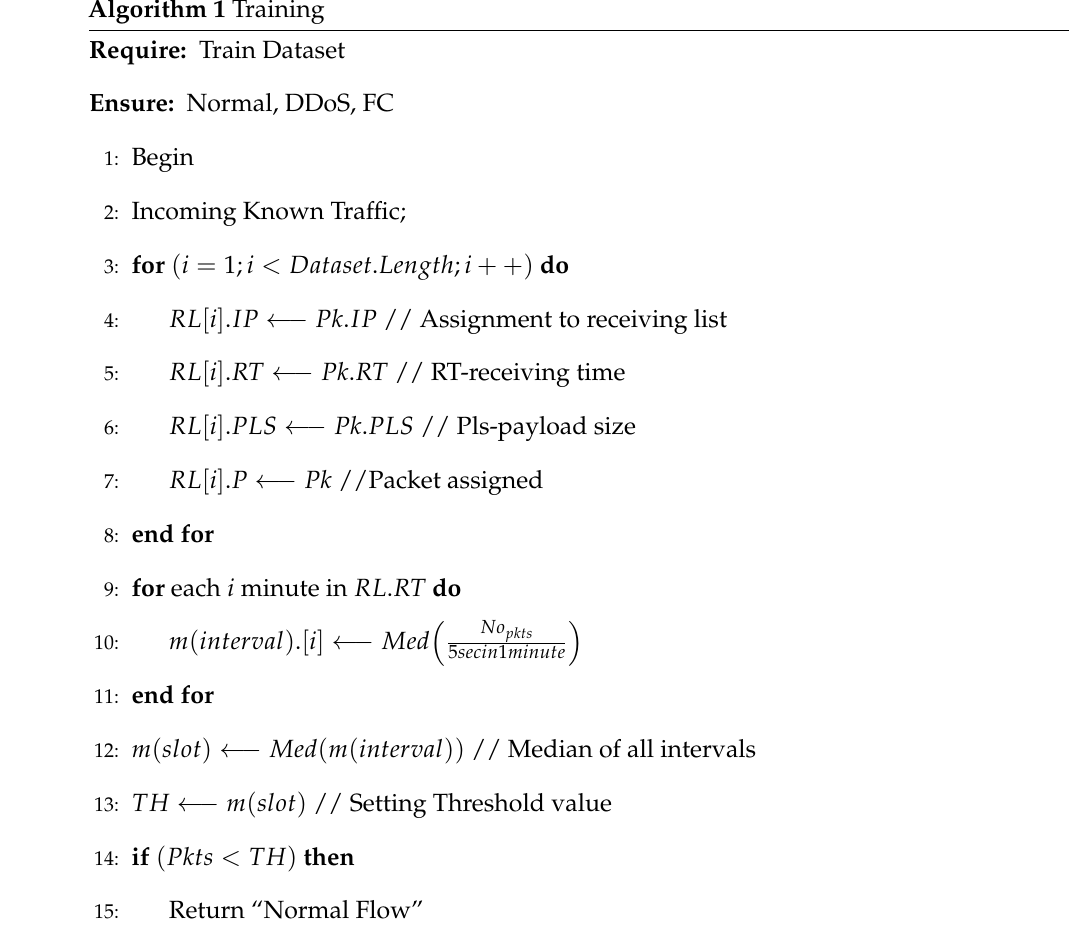
Algorithm 1 Training